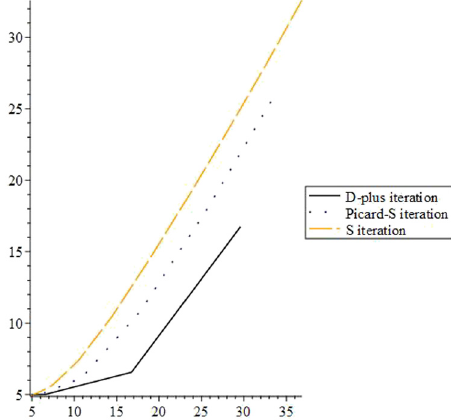
Figure 2: Convergence of D - plus iteration process when initial guess is